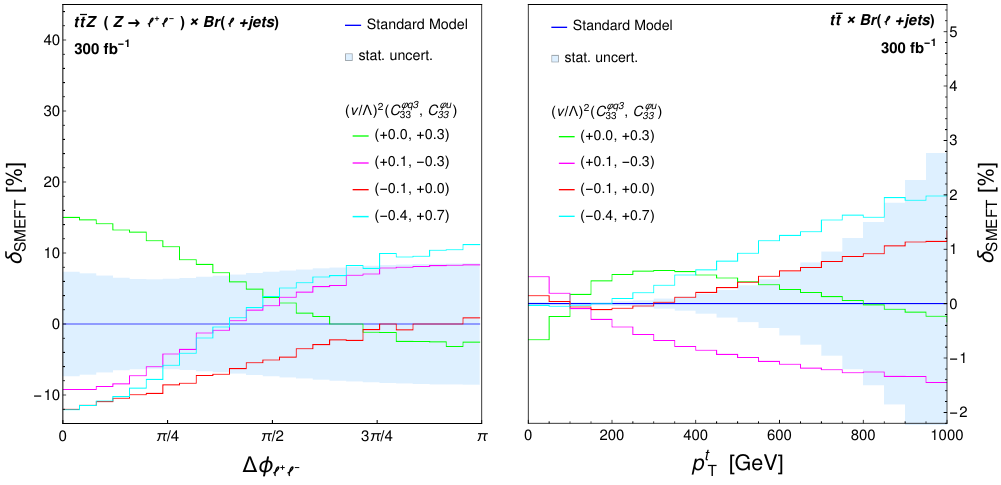
Figure 6 . Size of the relative modi(cid:12)cations due to SMEFT contributions (green, magenta, red, and cyan) with respect to Standard Model expectation (blue), after rescaling to account for systematic uncertainties. The light blue band shows statistical